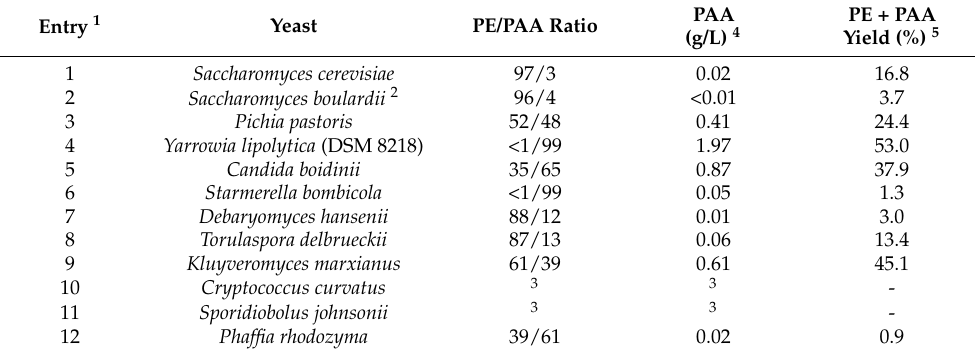
Table 2. Biotransformation of (L)-phenylalanine with long contact time and high aeration. Entry 1